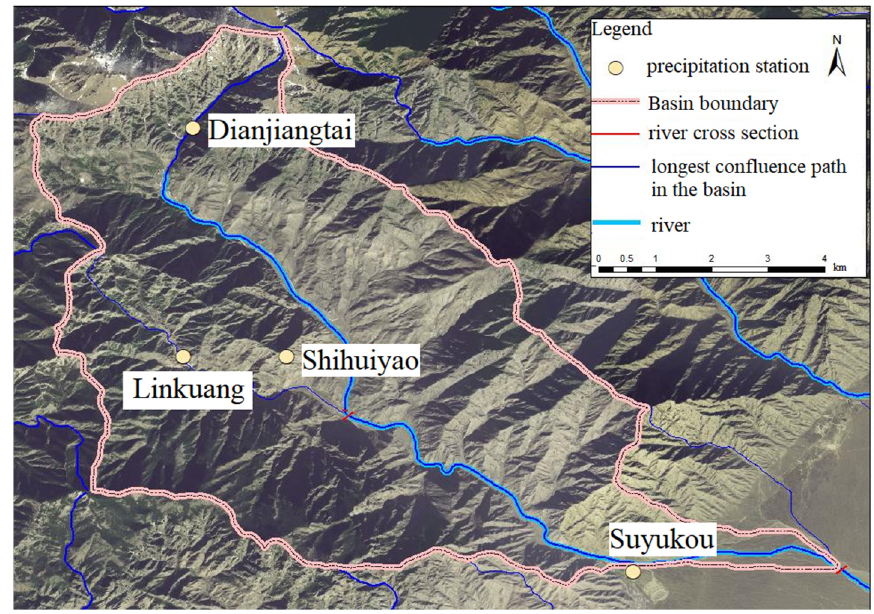
Figure 3. General situation of the basin and the distribution of rainfall stations.